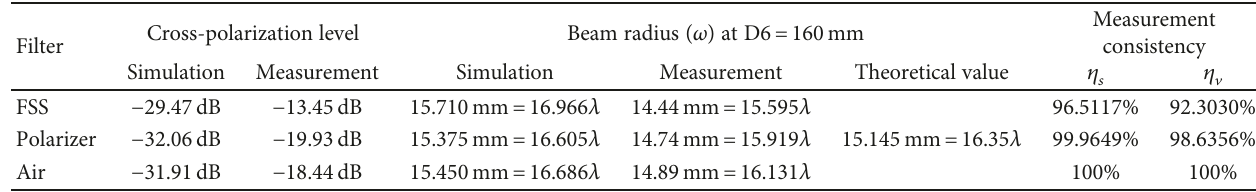
Figure 10: The near- fi eld measurement results of 324GHz channel in the dual-channel 3D QON system. From left to right are the measured plane of copolarization amplitude, the copolarization phase, the cross-polarization amplitude, and the cross-polarization phase. Table 2: The near- fi eld measurement data of 324 GHz